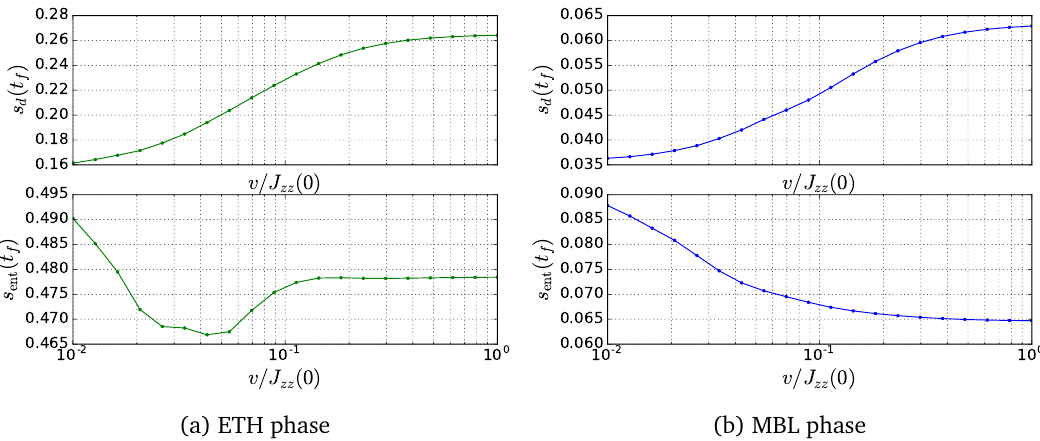
Figure 1: Diagonal and entanglement entropy densities as a function of the ramp speed in the MBL and delocalised (ETH) phases of the ramped disordered XXZ model. The ramped protocol ( t ) = ( 1 / 2 + vt ) J ( 0 ) . The parameters are J is chosen as J zz zz / J ( 0 ) = 0.1, and L = 10. Disorder averaging was performed over 1000 h zz ETH